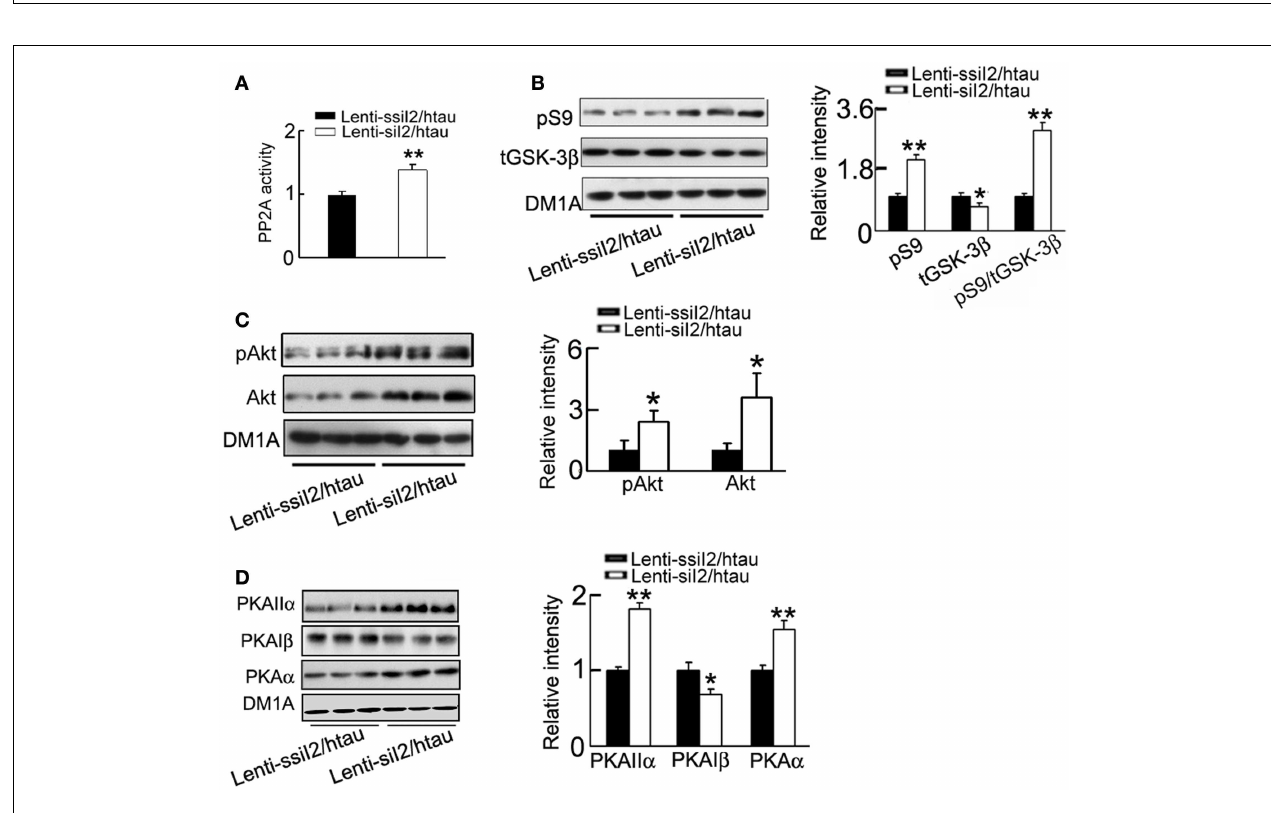
GSK-3 β (tGSK-3 β ) (B) , the levels of phosphorylated Akt at Ser473 (pS473-Akt) FIGURE 5 | Expression of Lenti - siI PP2A restores PP2A activity with 2 and total Akt (C) , and the levels of PKA α , PKAI β , and PKAII α (D) were inhibition of GSK-3 in htau mice . Approximately 11-month-old htau mice were treated as Figure 1 . (A) The activity of PP2A was measured by a PP2A measured byWestern blotting and quantitative analysis.The data were activity assay kit as described in the Section “Materials and Methods.” presented as mean ± SD of three independent experiments. * p < 0.05; ** p < 0.01 vs. Lenti-ssiI 2 /htau2 (htau mice infused with Lenti-ssiI 2 (B–D) The protein levels of the Ser9-phosphorylated GSK-3 β (pS9) and total